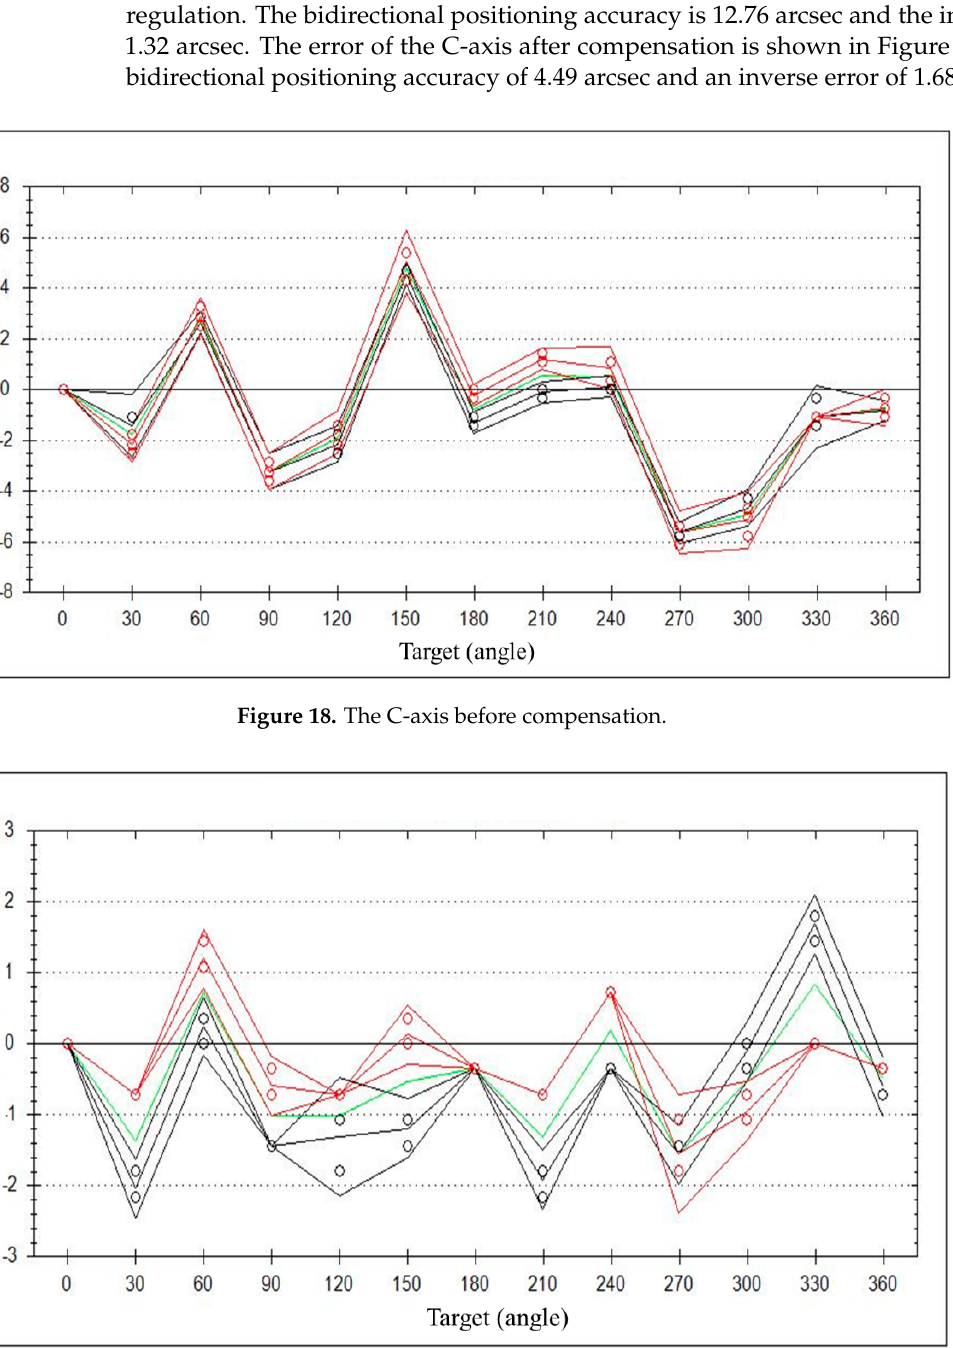
Figure 19. The C-axis after compensation.